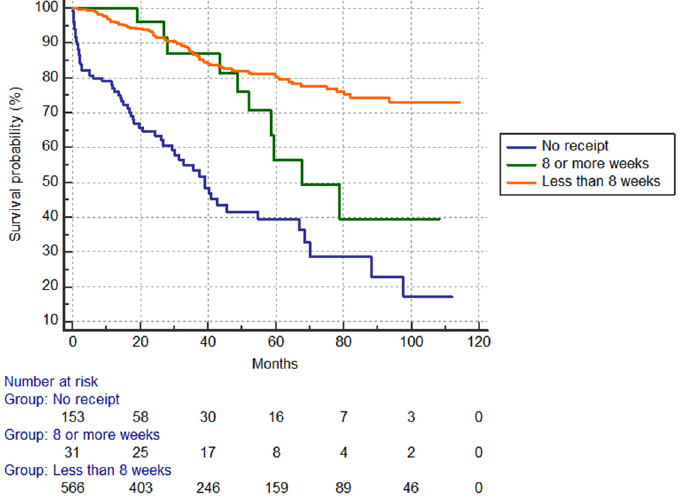
Fig 1. Overall survival according to use of adjuvant chemotherapy use. Five-year rates by group: 39.4% no chemotherapy; 56.5% delay (cid:1) 8 weeks; 80.1% < 8 weeks (p <